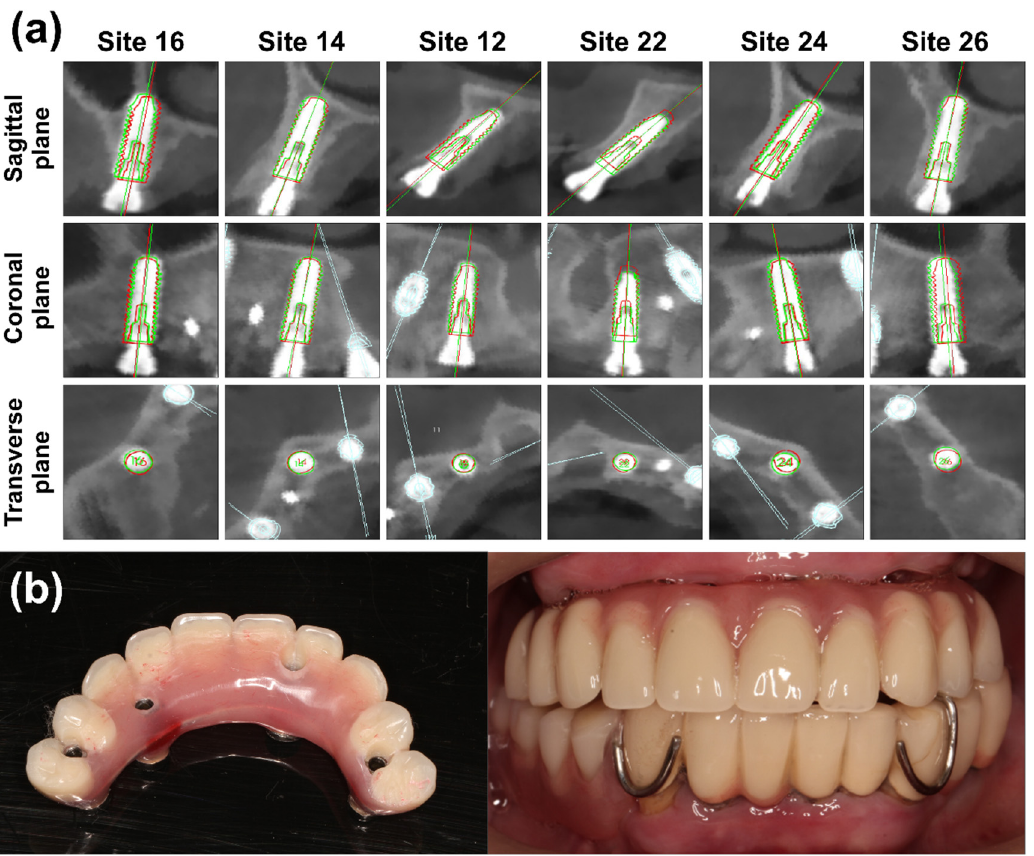
Figure 8. Postoperative evaluation. ( a ) Accuracy analysis for deviations between the planned and placed implants. The red profile indicates the planned implant, and the green profile shows the placed implant; ( b ) the immediately loaded provisional reconstruction.